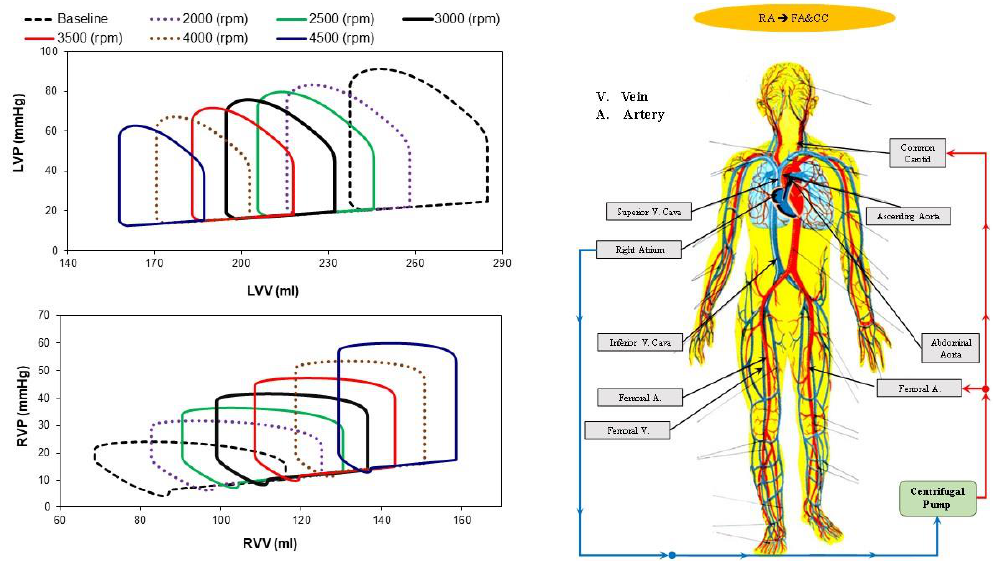
Figure 3. Top left panel ( bottom left panel ) shows the left (right) ventricular pressure–volume loops in baseline conditions (dashed black line) and for RA → FA&CC cannulation with centrifugal speed pump set to 2000 rpm (dashed lilac line), 2500 rpm (green line), 3000 rpm (continuous black line), 3500 rpm (red line), 4000 rpm (dashed brown line) and 4500 rpm (lilac line). The ventricular loops obtained using CARDIOSIM© were stored in excel files and subsequently plotted. The ( right panel ) shows the RA → FA&CC cannulation in which the centrifugal pump draws blood from the right ventricle and ejects it in the femoral artery and common carotid artery bilaterally.